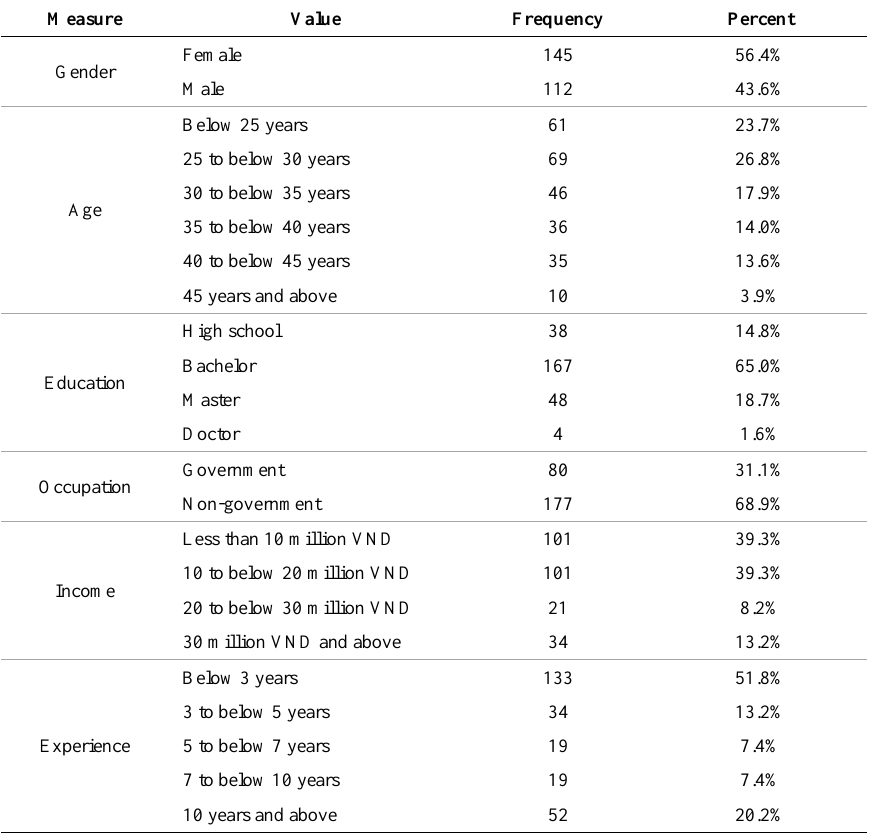
Table 1. Respondents’